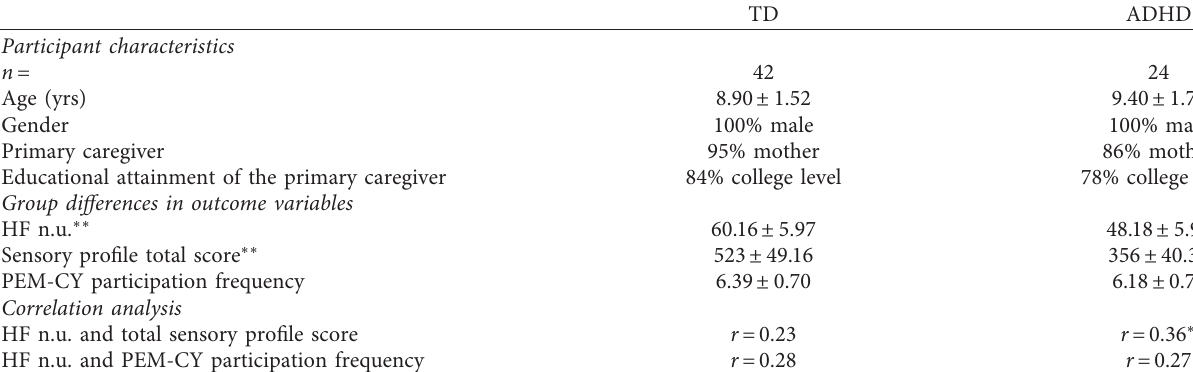
Table 1: Summary table of salient